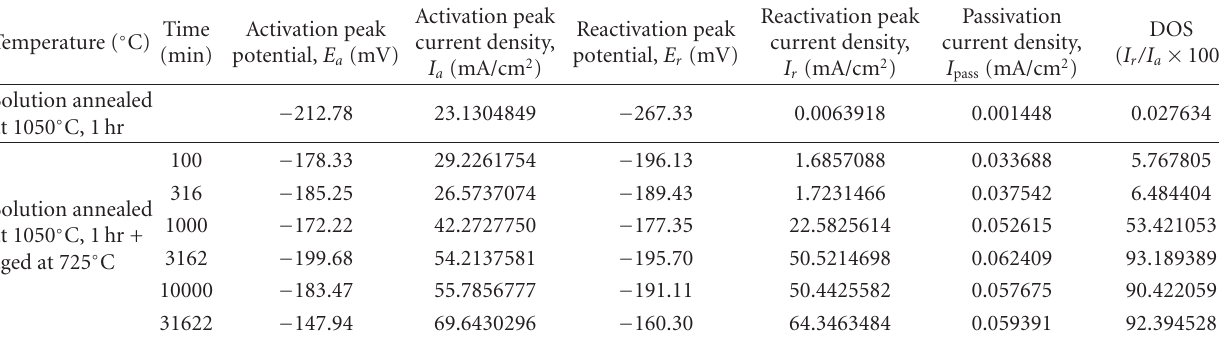
Table 5: DLEPR Test results of 2205 type duplex stainless